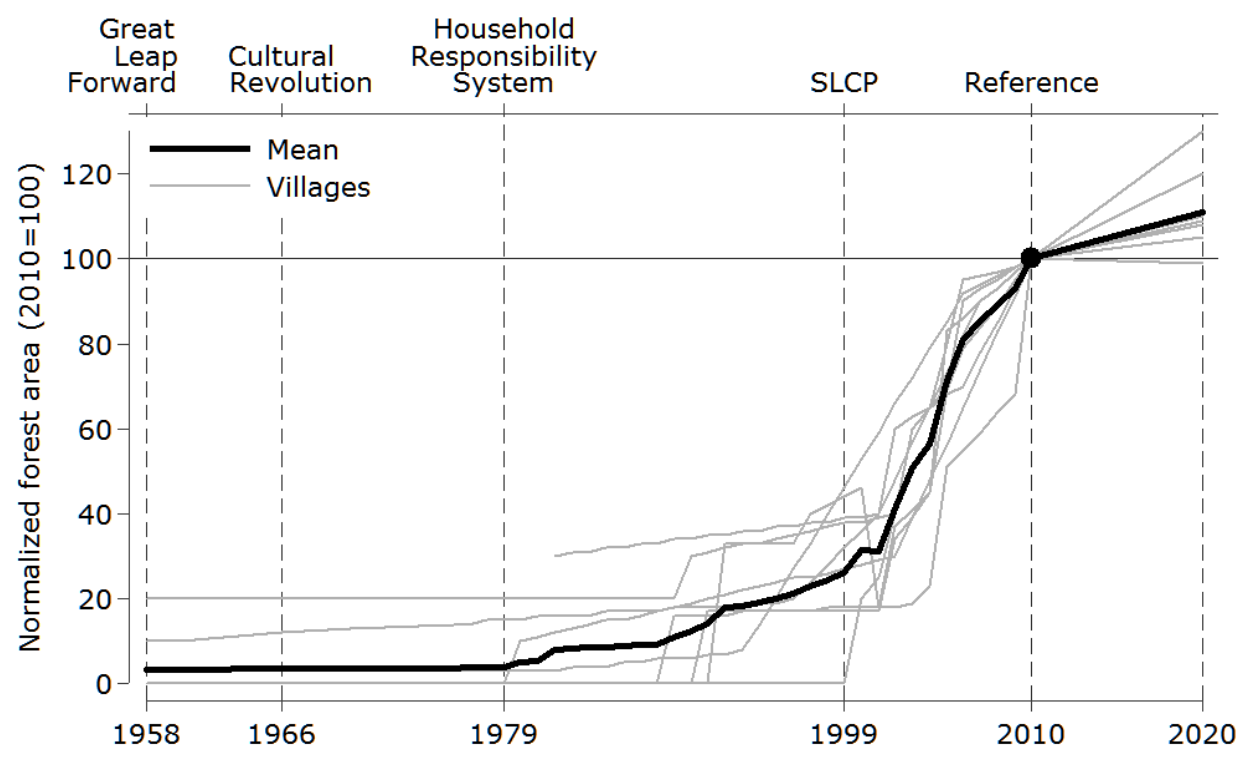
Figure 4. Emergence of plantation